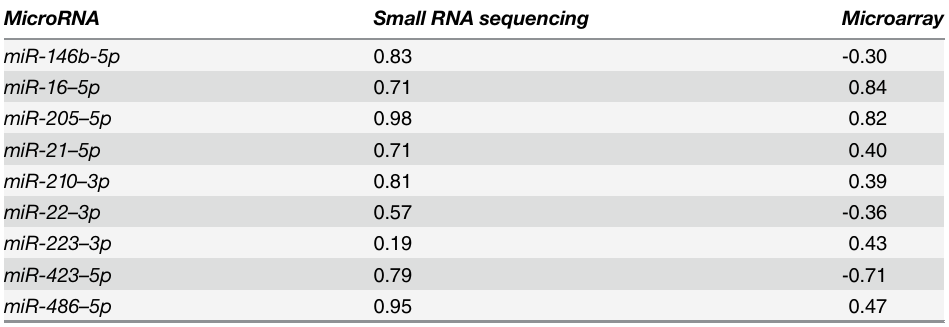
Table 2. Spearman correlation coefficients of normalized microRNA measurements obtained by re- verse-transcription (RT)-PCR and the small RNA sequencing or microarray platforms a .